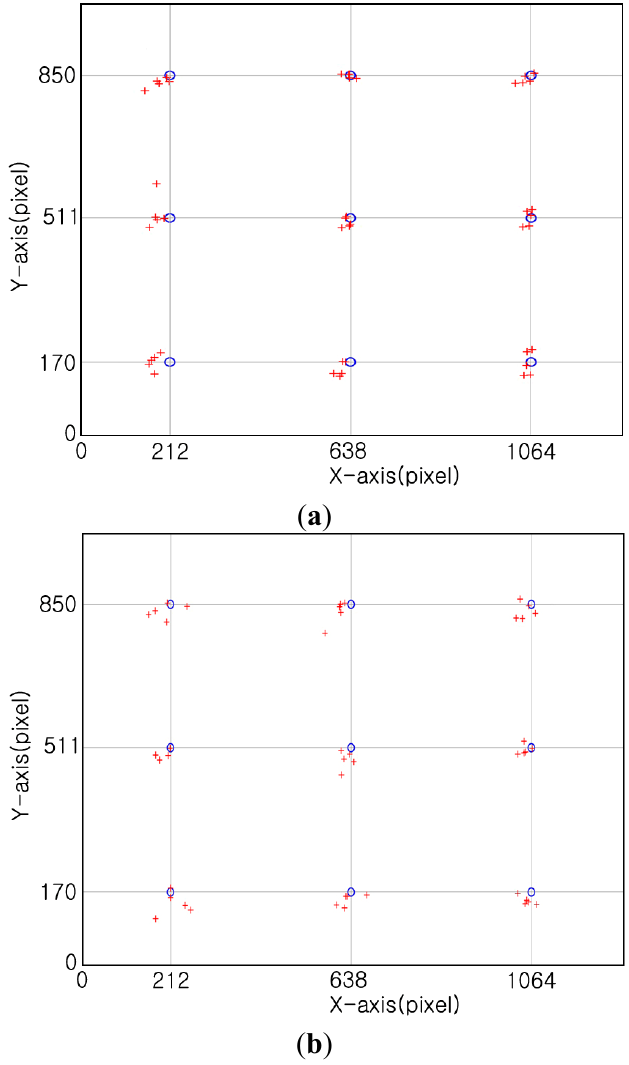
Figure 13. Example of the calculated gaze positions based on the nine reference points (five trials of one person) (the “ ◦ ” symbols signify the reference points and the “+” signs are the detected gaze points) ( a ) User is not wearing glasses ( b ) User is wearing